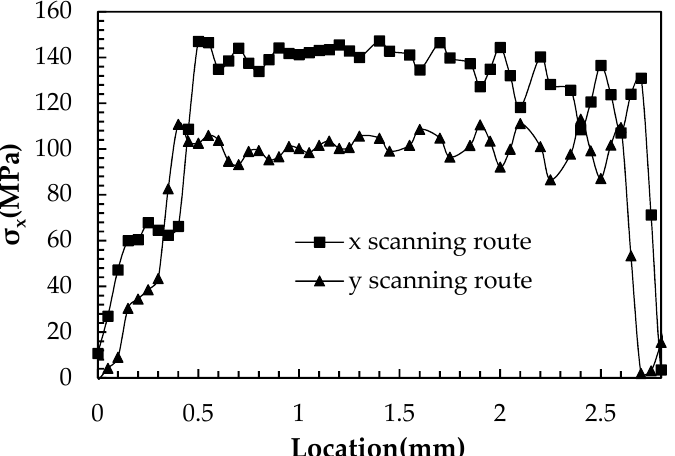
Figure 10. Residual stress σ x distribution of the specimens under different scanning strategies as they are cooled to room temperature: ( a ) the x scanning route; and, ( b ) the y scanning route.